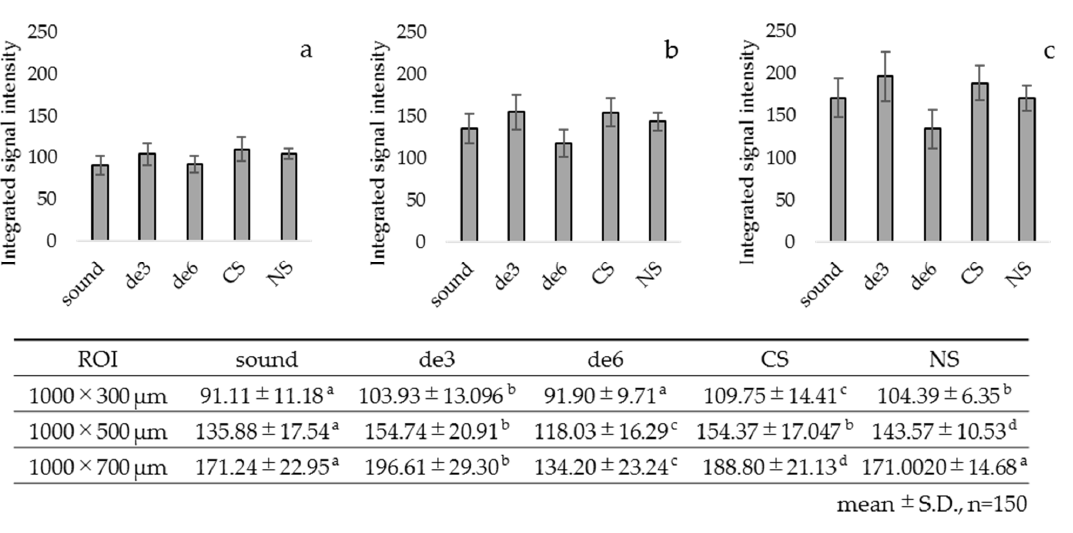
Figure 7. Attenuation coefficient (µt) in each ROI. CS and NS showed intermediate values between the sound and de6. ( a ) ROI 1000 × 300 µm 2 , ( b ) ROI 1000 × 500 µm 2 , and ( c ) ROI 1000 × 700 µm 2 . The same lowercase letters indicate no significant differences among the values ( p > 0.05). (One-way ANOVA with Tukey’s post hoc).